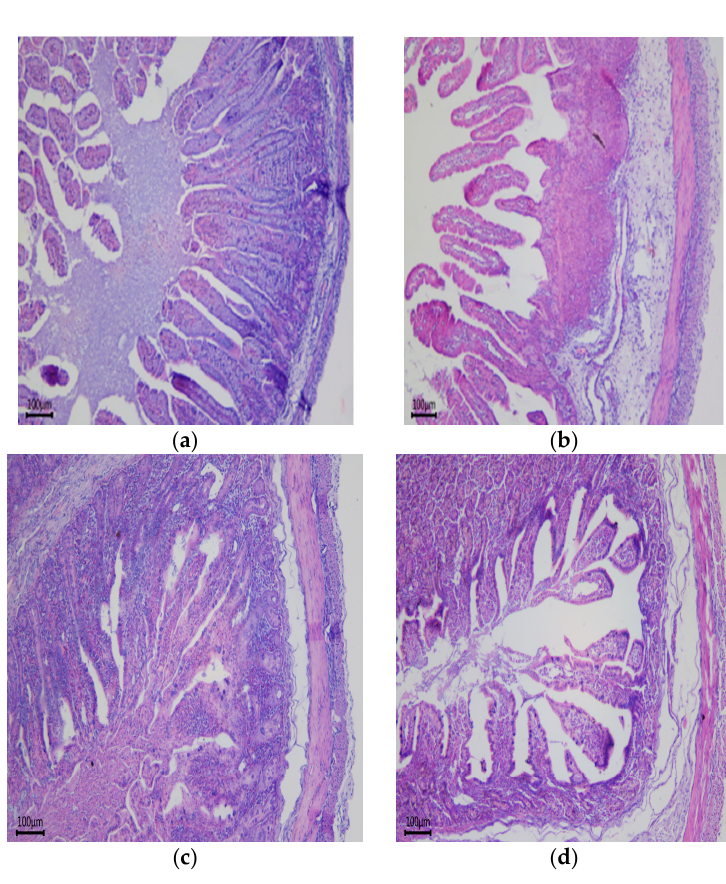
Figure 1. Jejunal histomorphology of newborn and weaning piglets. ( a,c ) indicate the control diet (CON); ( b , d ) indicate the low-energy diet (LED). ( a , b ) show the newborn piglets’ jejunal histomorphology; ( c , d ) show the weaning piglets’ jejunal histomorphology. Intestinal villi in ( b , d ) were shorter compared with the same period ( a , c ). Original magnification: 200 × . ( n = 6 for each